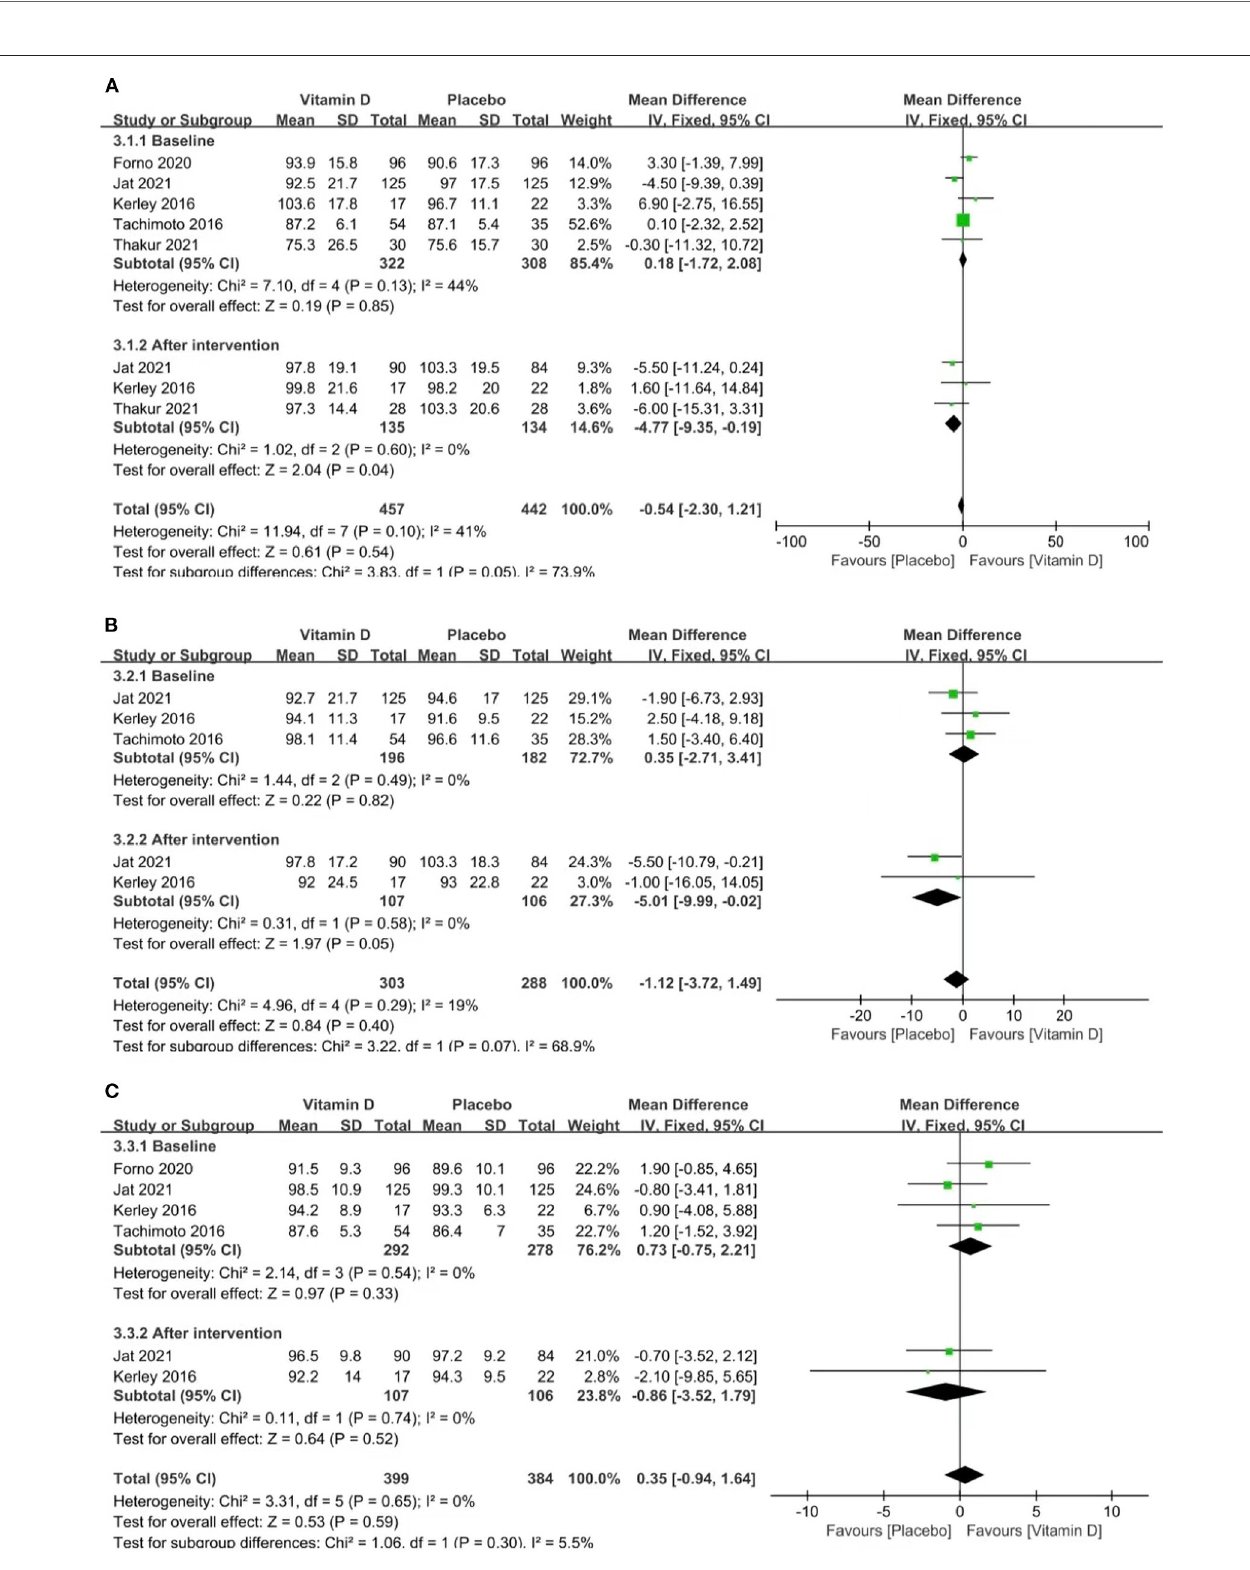
FIGURE 4 | Forest plots MD of FEV1% (A) , FVC% (B) , and FEV1: FVC (C) associated with vitamin D vs. placebo.